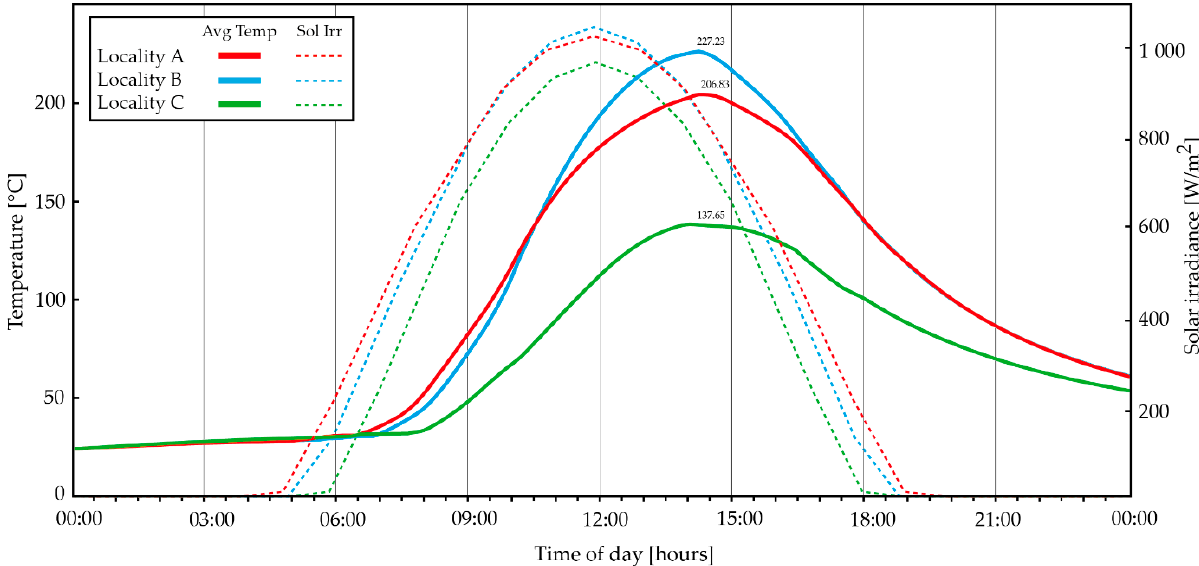
Figure 10. Time course of the change in the average temperature of heat accumulators and intensity of the solar radiation.